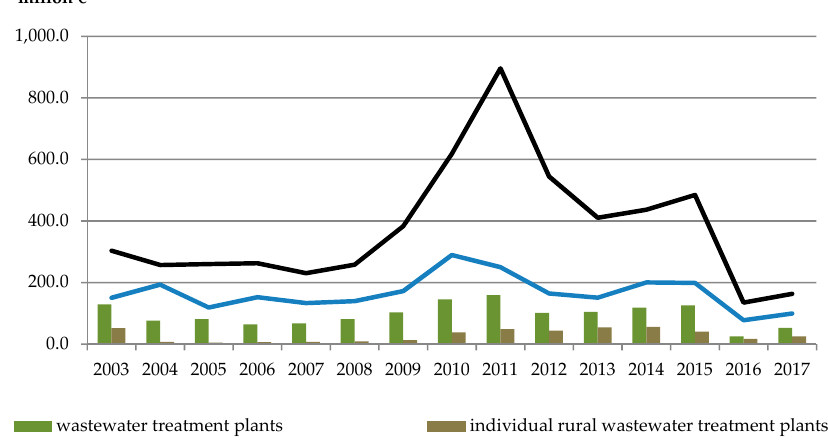
Figure 4. Expenditure on selected elements of water and sewage management in rural Poland